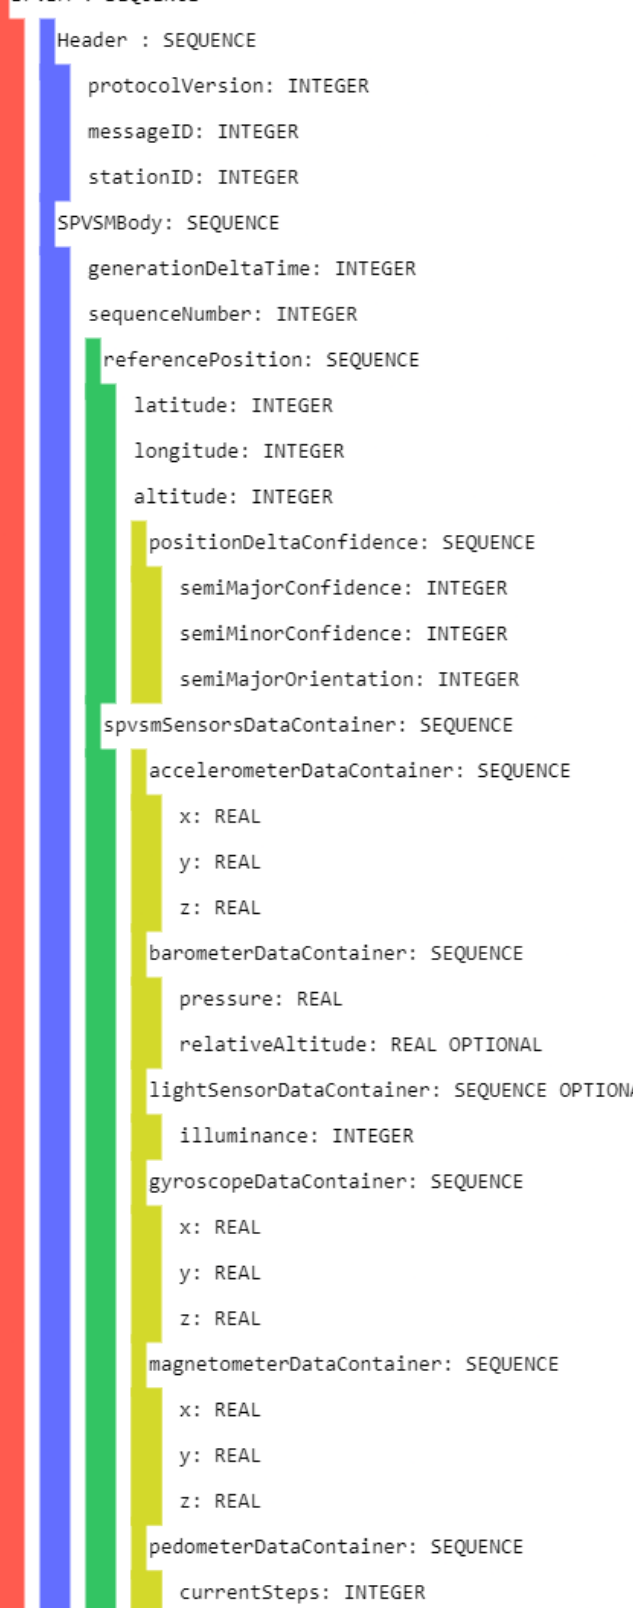
Figure A2. SPVSM ASN.1 message